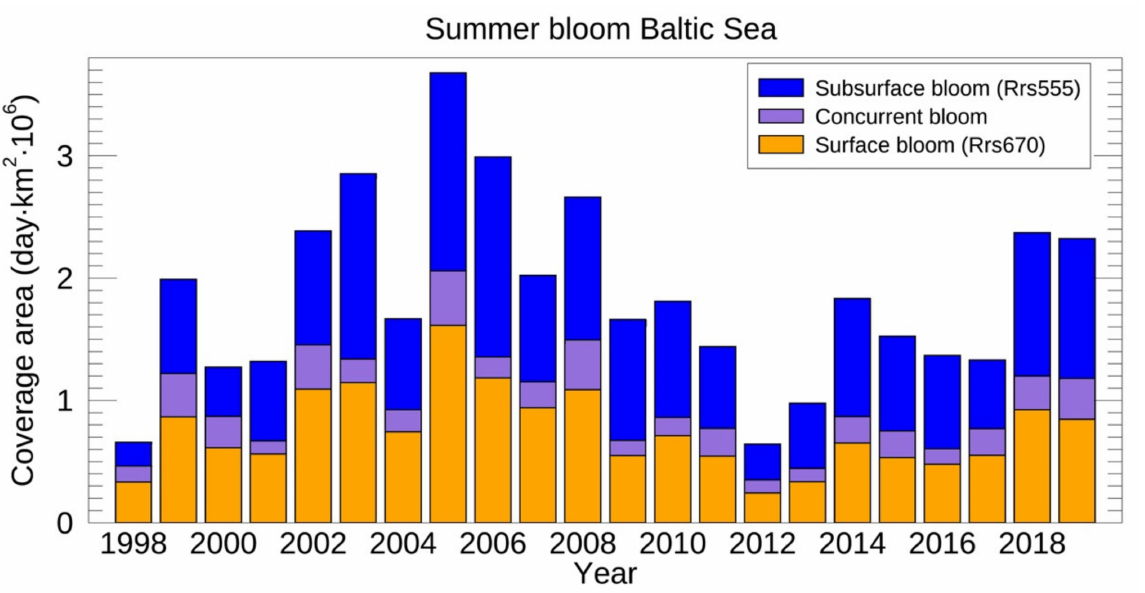
Figure 10. Summer subsurface and surface bloom coverage time series for the whole Baltic Sea. Concurrent bloom are the areas where both surface and subsurface thresholds were